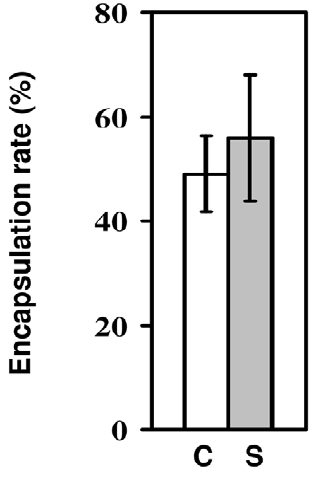
Figure 5. Encapsulation ability of larvae selected for fungal resistance. Rate of encapsulation of Asobara tabida eggs by Drosophila melanogaster larvae which had either been selected for tolerance to Beauveria bassiana (S; grey bar) or had not been selected (U; white bar). Bars show mean 6 s.e.